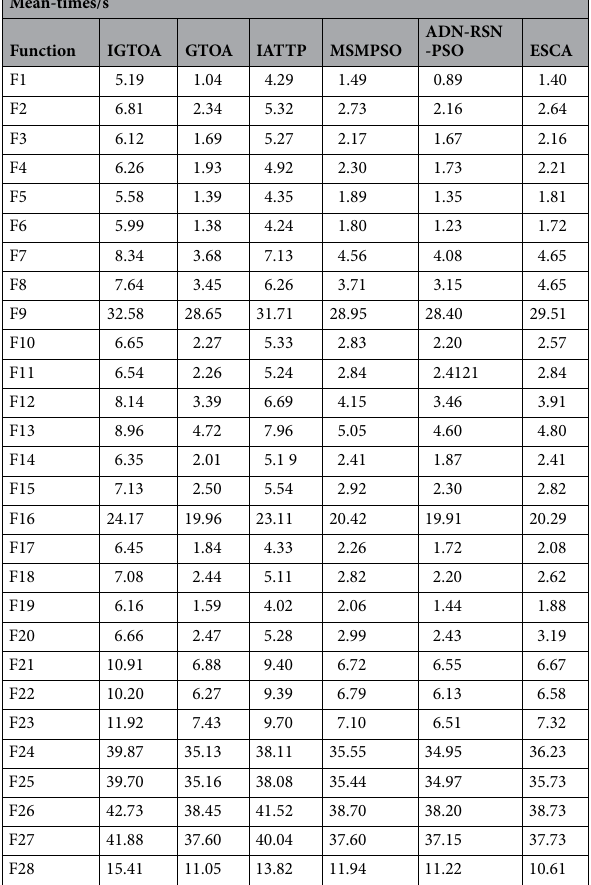
Table 9. Comparison of time complexity between IGTOA and other algorithms.